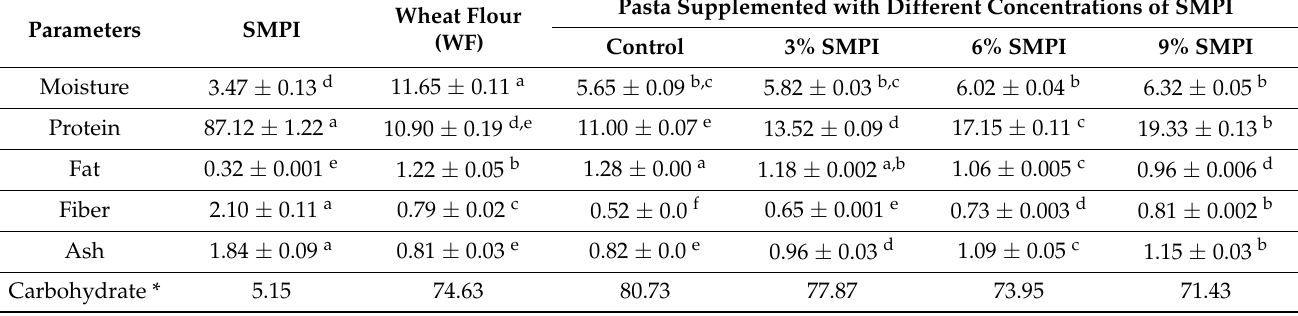
The values are the mean ± SD of three replicates. The values in the same row followed by different letters are significantly different ( p < 0.05). * by